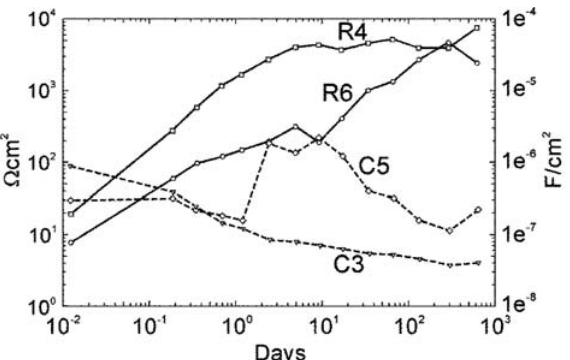
Figure 5. The impedance spectra parameters obtained using circuit #1 as a function of time for cell G40A. C3 was calculated using eq.(8). The values are given in area specific units.